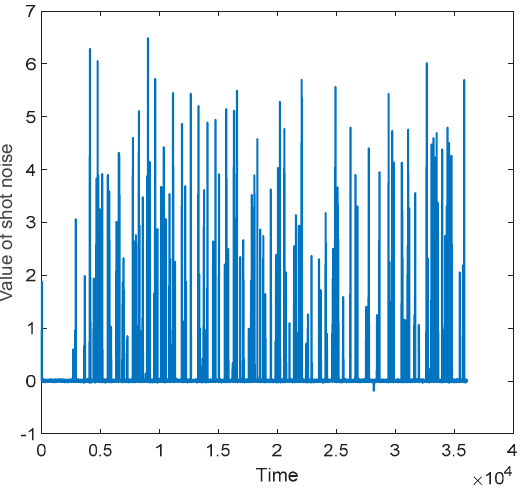
Figure 8. Shot noise in measured output.